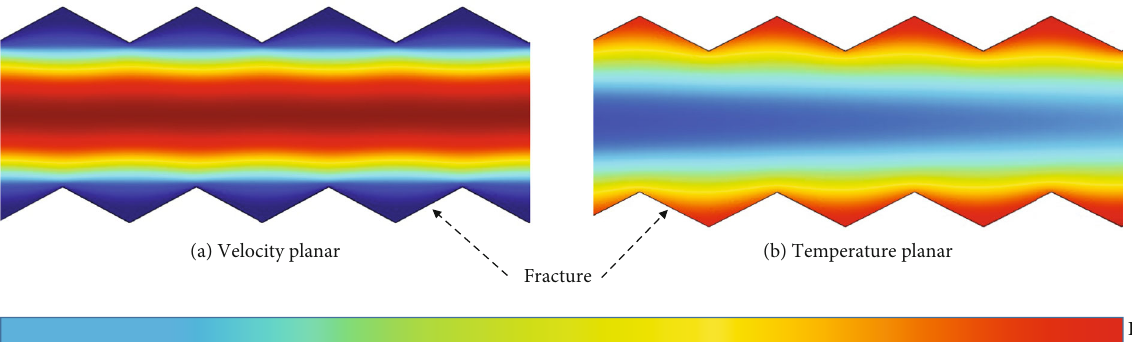
Figure 11: Velocity and Temperature distribution in fracture.